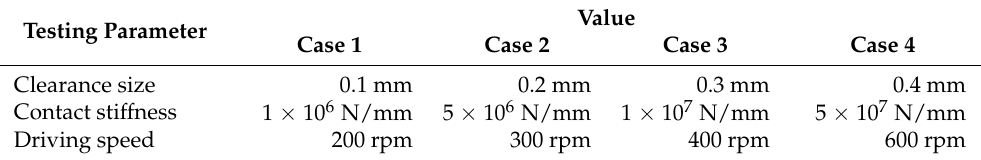
Table 3. Parametric studies for different cases.